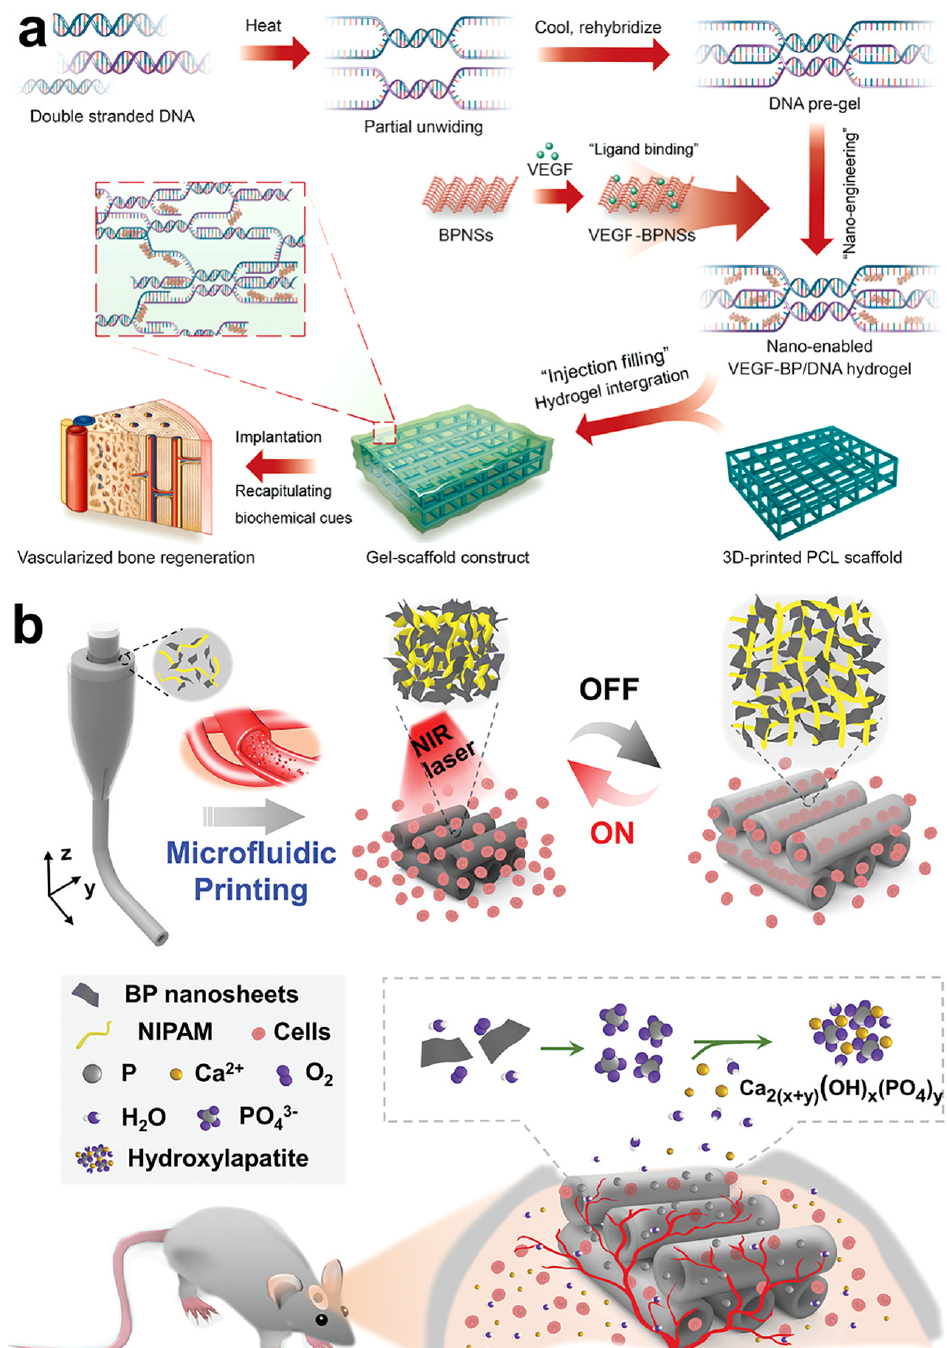
Figure 5. ( a ) DNA − PCL scaffolds loaded with vascular endothelial growth factor (VEGF) − modified black phosphorus (BP) nanosheets (BPNs) achieve vascularized bone regeneration by releasing VEGF; reproduced with permission from [77], Bioactive Materials, 2023. ( b ) Microfluidic three − dimensional printed scaffolds containing BPNs can achieve reversible contraction and expansion of the scaffold under the irradiation of near − infrared light. Thereby, these promote the penetration of vascular endothelial cells into the scaffold and induce vascularized bone regeneration. Reproduced with permission from [105], Advanced Functional Materials,